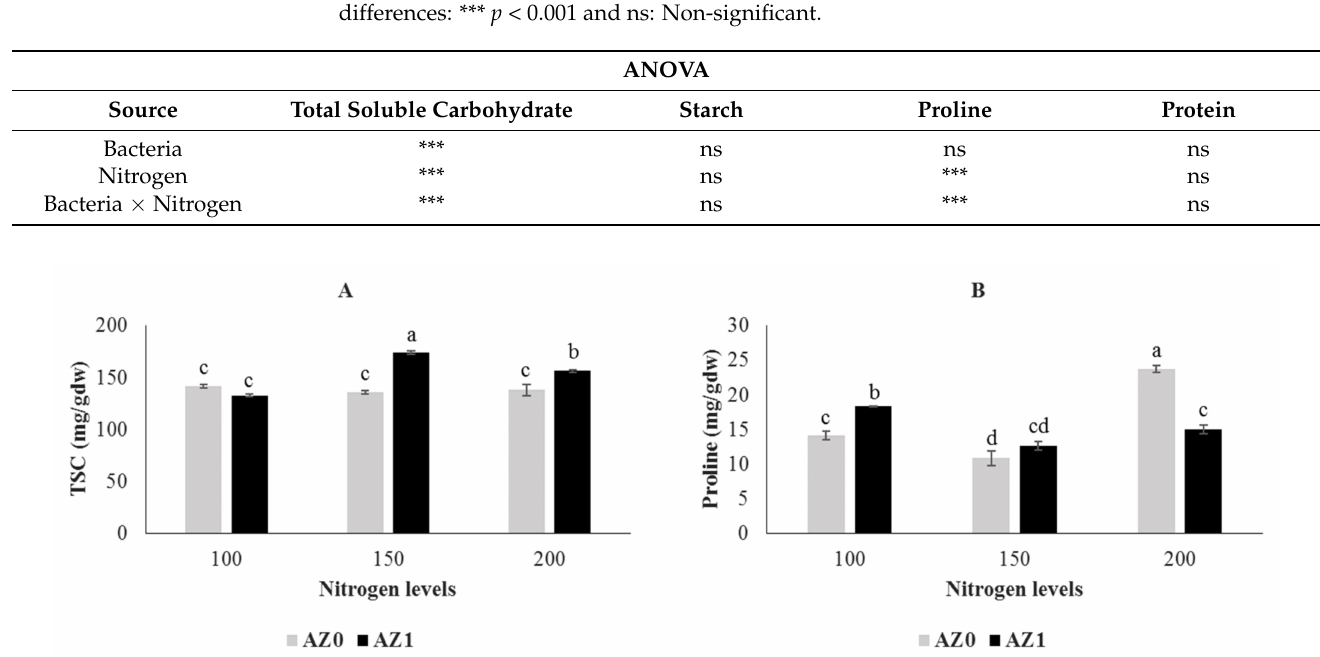
Table 4. Total soluble carbohydrate, starch, proline and protein contents in hydroponically grown lettuce influenced by Azotobacter under different nitrogen levels. The mean comparison using LSD test ( p < 0.05) was implemented for examining the differences among the treatments. Significant